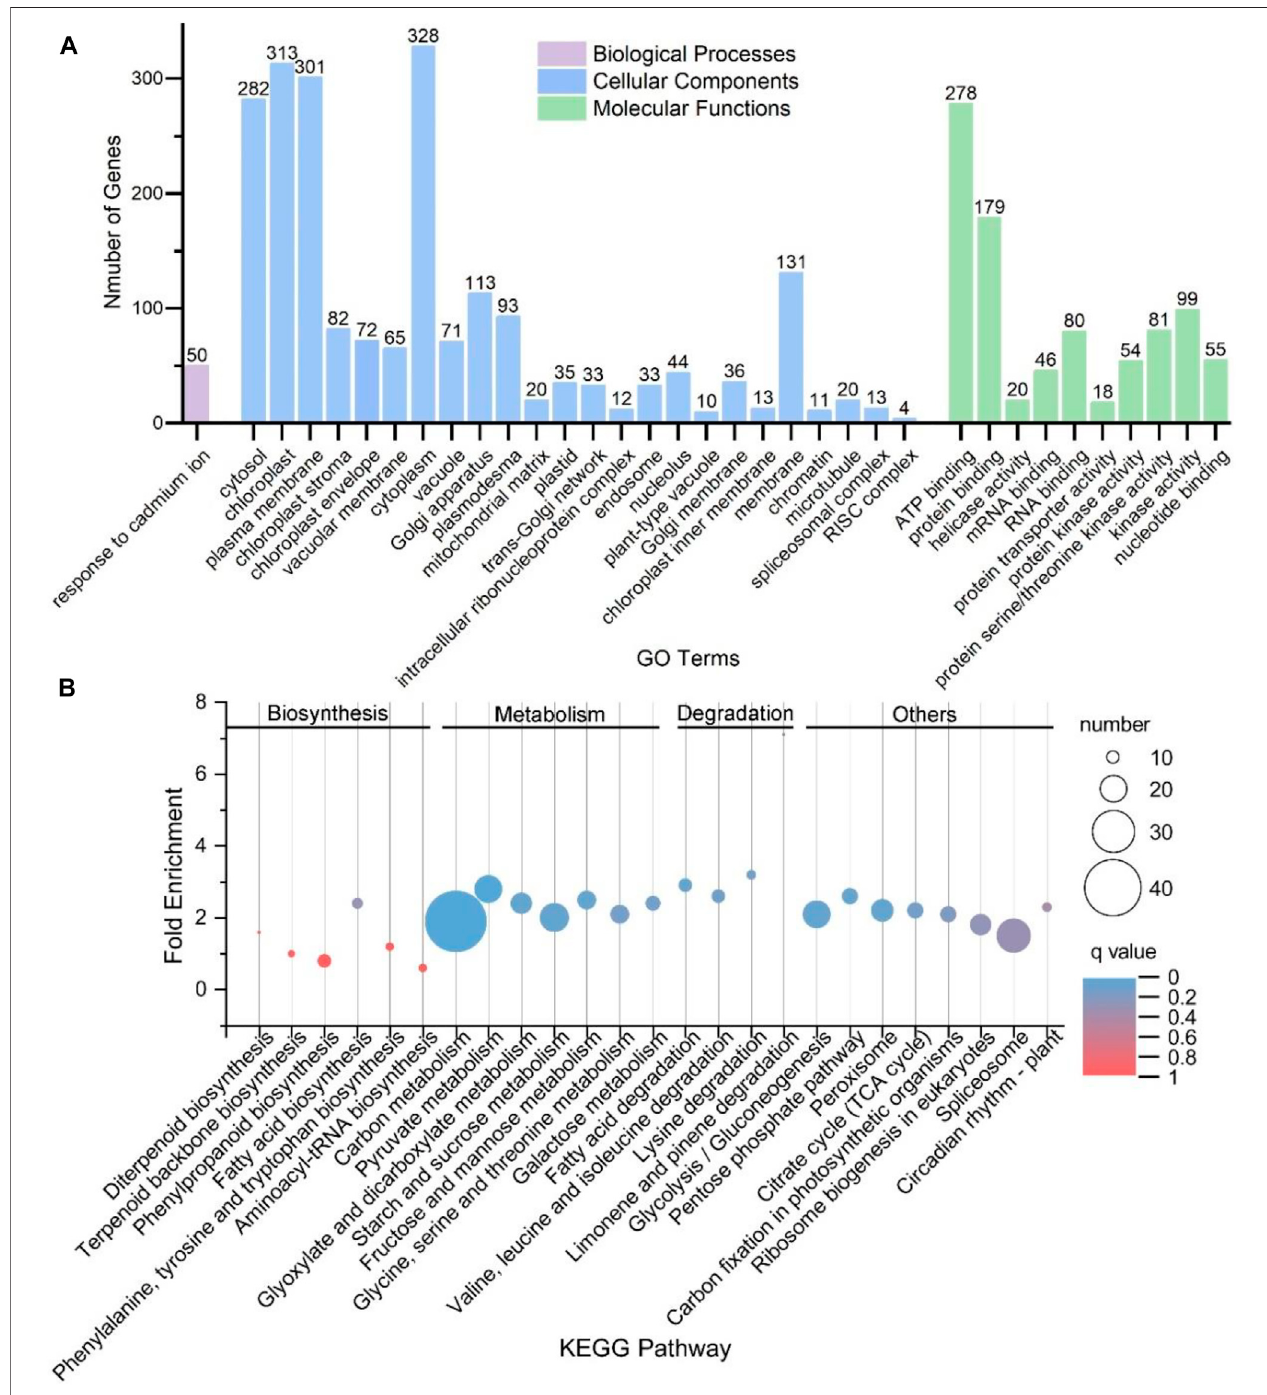
FIGURE4| FunctionalenrichmentanalysesforparentalgenesofcircRNAs in S.miltiorrhiza . (A) Thirty- fi vesigni fi cantlyenriched GOtermsfortheparentalgenesof circRNAs. The X-axis shows the names of the GO terms. The Y-axis shows the number of genes belonging to each GO term. These terms are classi fi ed into three categories:Biological Processes (purple), Cellular Components(blue), and Molecular Functions (green). The terms witha q -value < 0.05and aminimumgenecount of3 wereconsidered signi fi cantlyenriched. (B) KEGG pathways fortheparental genesofcircRNAs withaminimumgenecount of3.TheX-axisshows thenameofthe pathways.TheY-axisshowsthe “ FoldEnrichment. ” Thepathwaysaredividedintofourcategories:Biosynthesis,Metabolism,Degradation,andothers,whichareshown above the fi gure. The size of the circle correlates with the number of genes. The color of the circle indicates different q values.